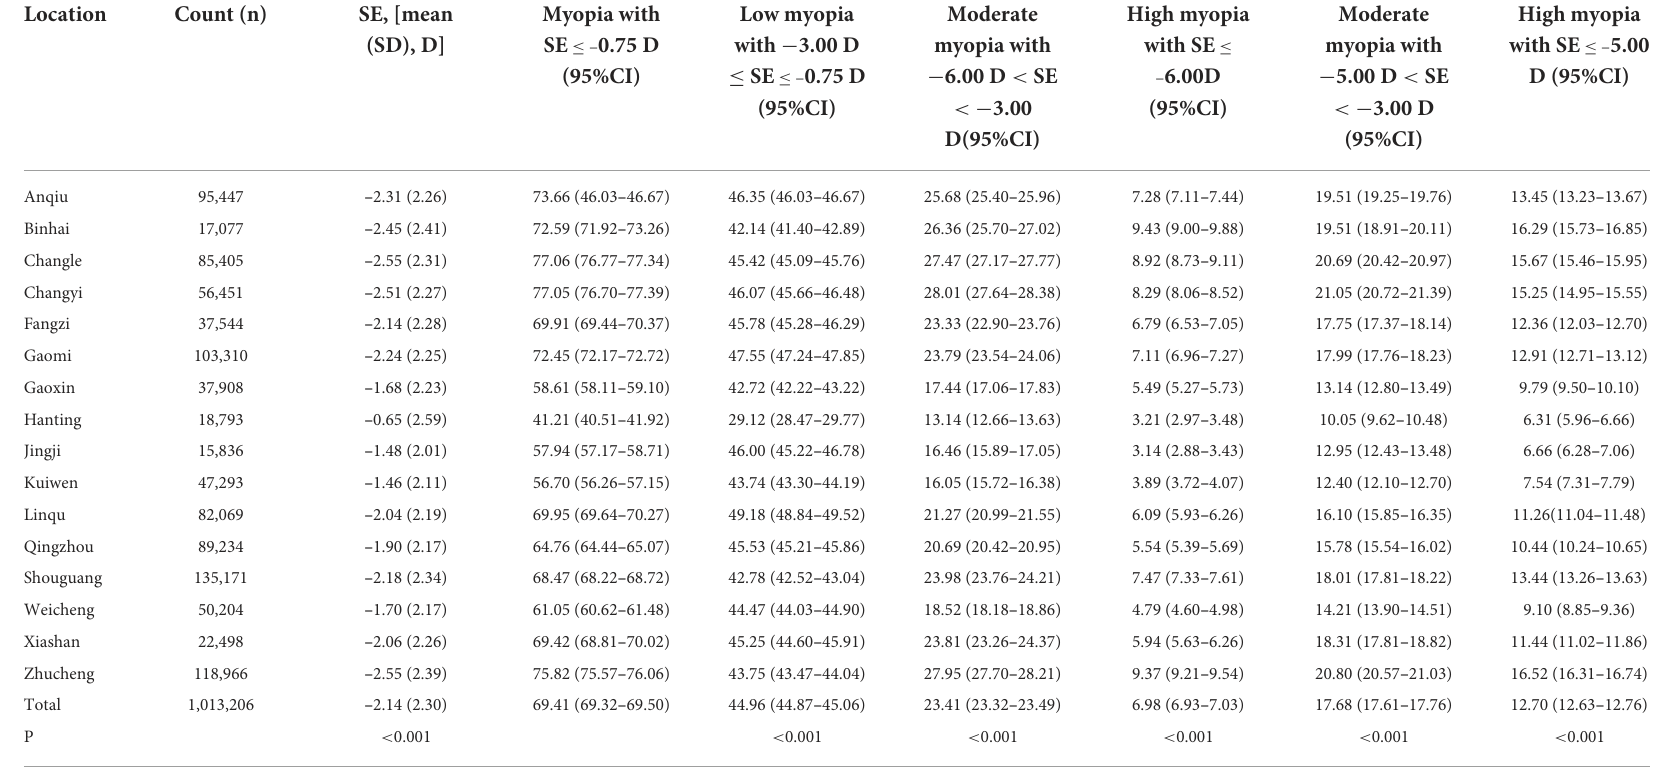
TABLE 1 Distribution of different grades of myopia in different regions